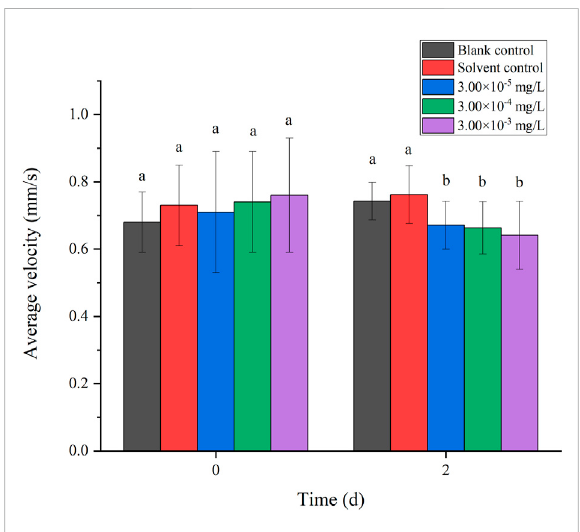
FIGURE 5 Effects of tebuconazole on the average velocity of zebra fi sh larvae locomotion.